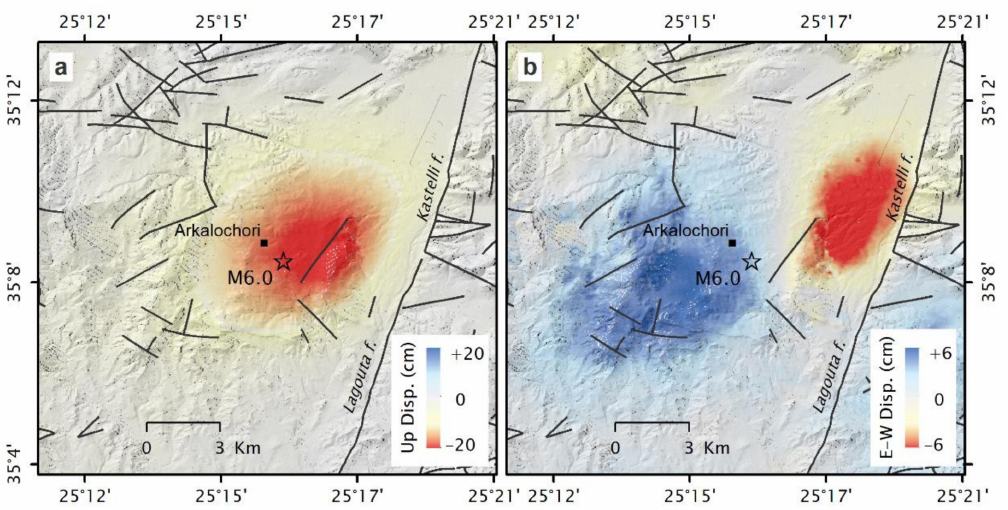
Figure 11. Vertical ( a ) and E-W ( b ) ground displacement maps as decomposed using Sentinel-1 DInSAR LoS observations from ascending A102 and descending D036 tracks (see Table 1). Black lines correspond to fault zones (after [3]). The relocated epicenter of the 27 September 2021 mainshock is marked with a